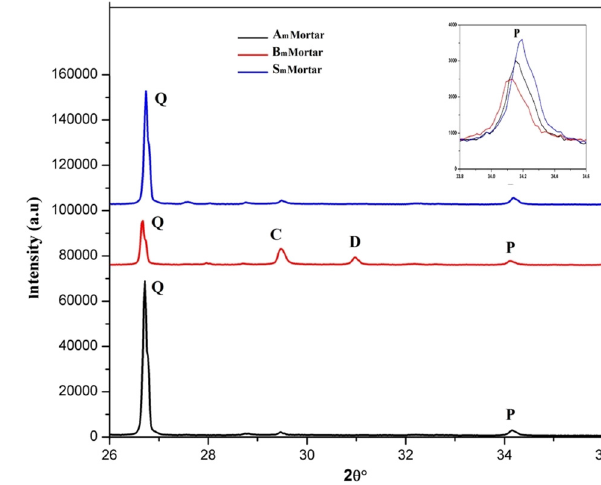
Figure 5: XRD of mortars Am, Bm and Sm samples.